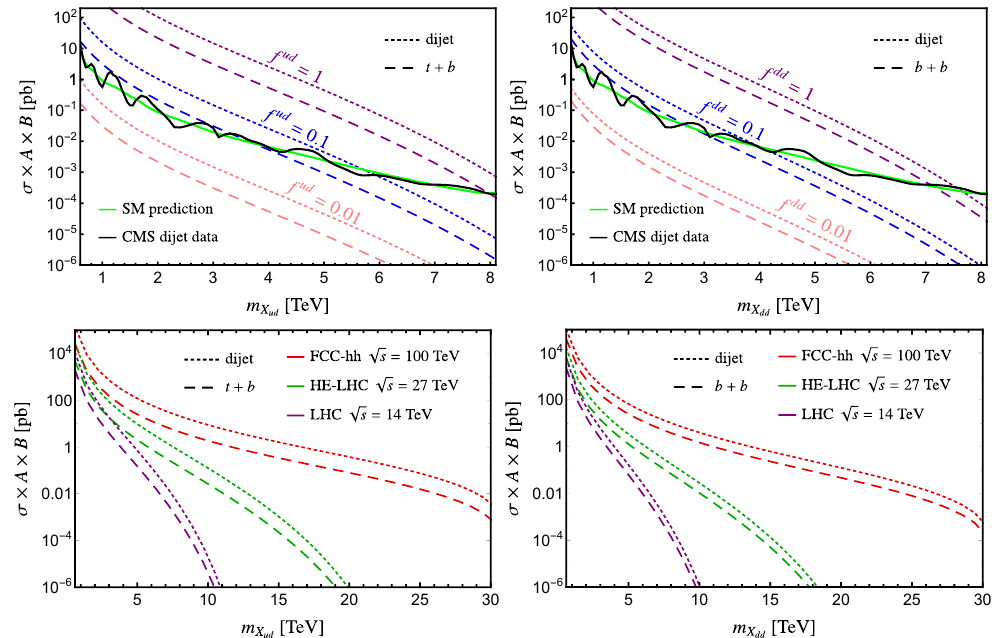
Figure 10 . Cross section of the scattering u + d → X ud → dijet ( t + jet ) (left column) and d + d → X dd → dijet ( b + b ) (right column), multiplied by the corresponding experimental acceptance A and branching ratio BR, as a function of the diquark mediator mass. In the top left (right), the cross sections for three different values of the diquark coupling f ud ( f dd ) at 13 TeV center-of-mass energy at LHC are shown, for f = 1 . 0 , 0 . 1 , and 0 . 01 , corresponding to purple, blue, and pink lines, respectively. The short-dashed lines correspond to the total cross section into dijet final state, and the long-dashed lines correspond to final state with third generation quarks. In black and green are the experimental data and corresponding SM prediction for a dijet final state search at the CMS experiment with 13 TeV center-of-mass energy and an integrated luminosity of 36 fb − 1 . In the bottom row, the projected cross sections for f = 1 at LHC, HE-LHC and FCC-hh are